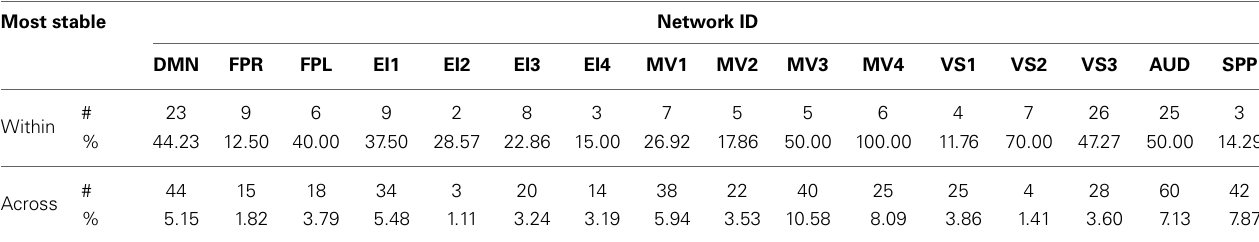
Table 4 | Absolute (#) and relative (%) number of connections with positive low CVAR (most stable) for each network. Most